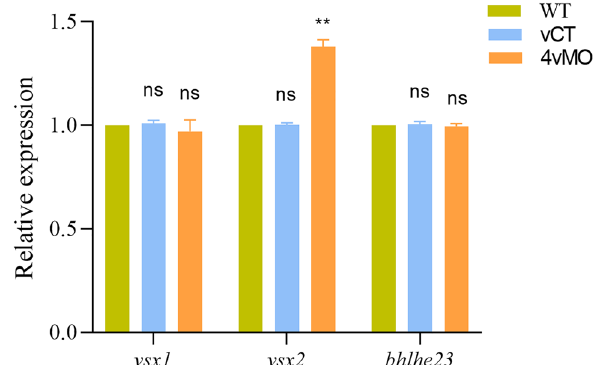
Figure 4. Effects of lhx4 knockdown via vivo - MO in the eyes on the expression of vsx1 , vsx2 , and bhlhe23 at 60 hpf. ns, P > 0.05; **, P < 0.01; ***, P < 0.001; ****, P < 0.0001; vCT vs. WT; 4vMO vs. vCT. Results are presented as mean ± SEM (n = 3 biological